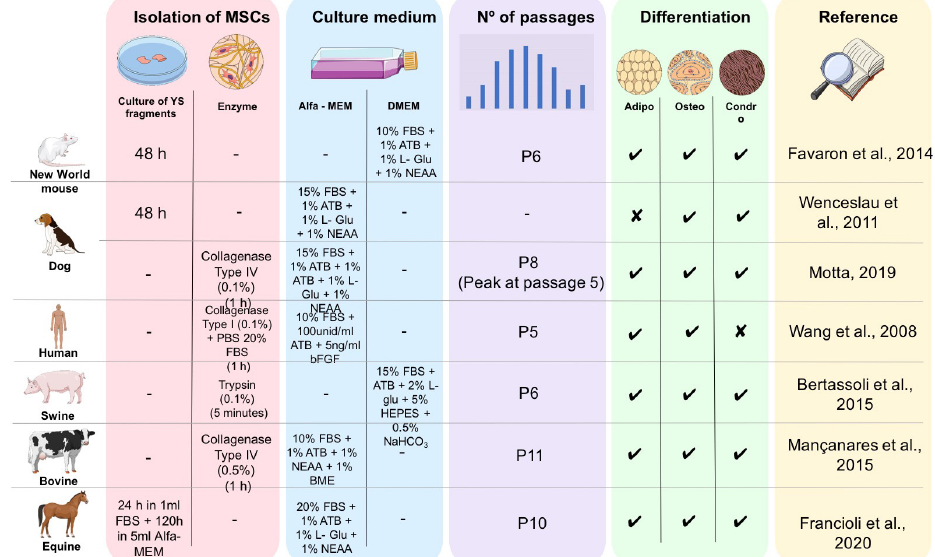
Figure 2. Methodologies applied for the isolation of the mesenchymal stem cells from the yolk sac of different animals. Alfa-MEM: α -minimum essential medium; ATB: antibiotic solution; bFGF: beta fibroblast growth factor; BME: beta-mercaptoethanol; DMEM: Dulbecco’s Modified Eagle Medium; L-Glu: L-glutamine; NEAA: nonessential amino acids; YS: yolk